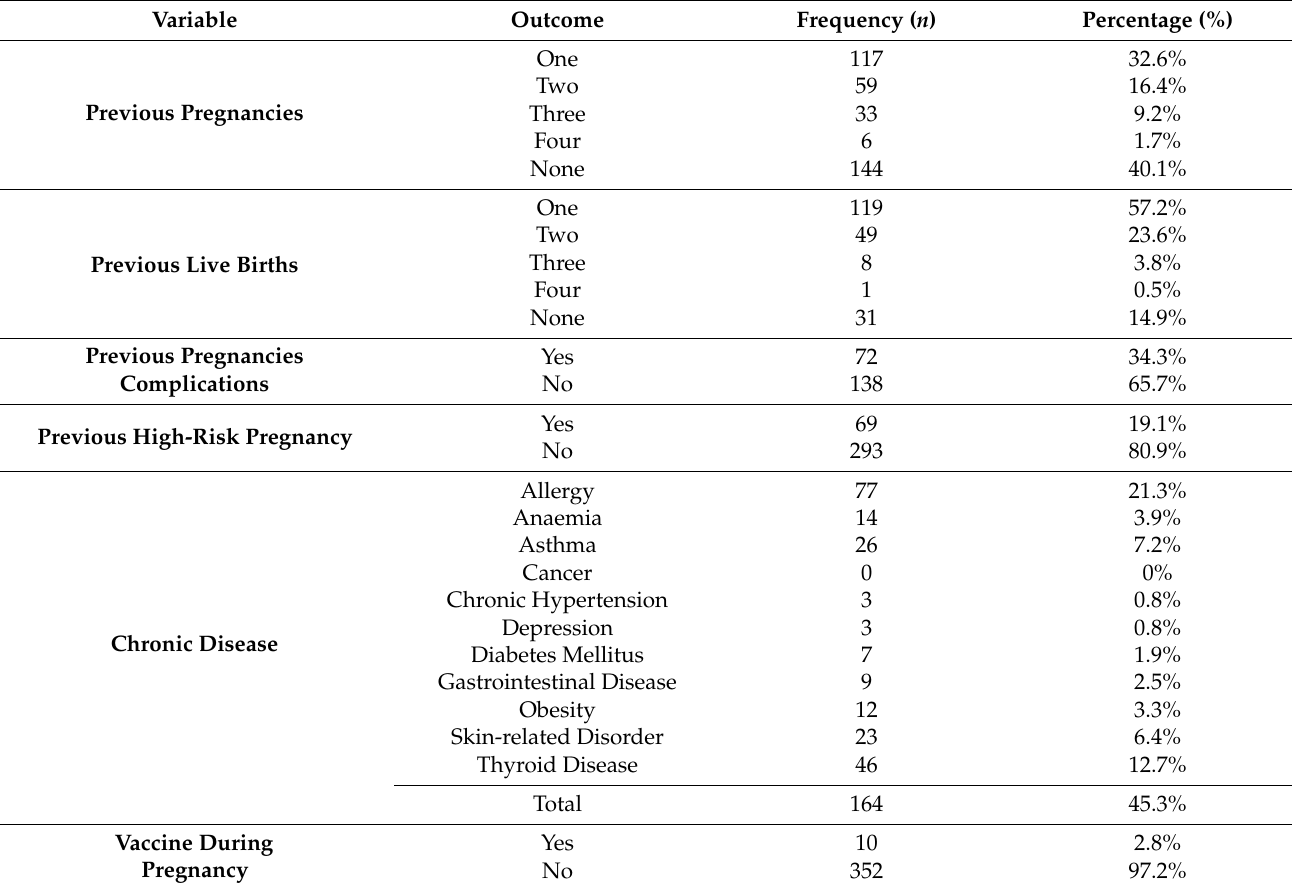
Table 2. Anamnestic characteristics of pregnant and lactating women (PLW), University Hospital Brno, August–October 2021 ( n =